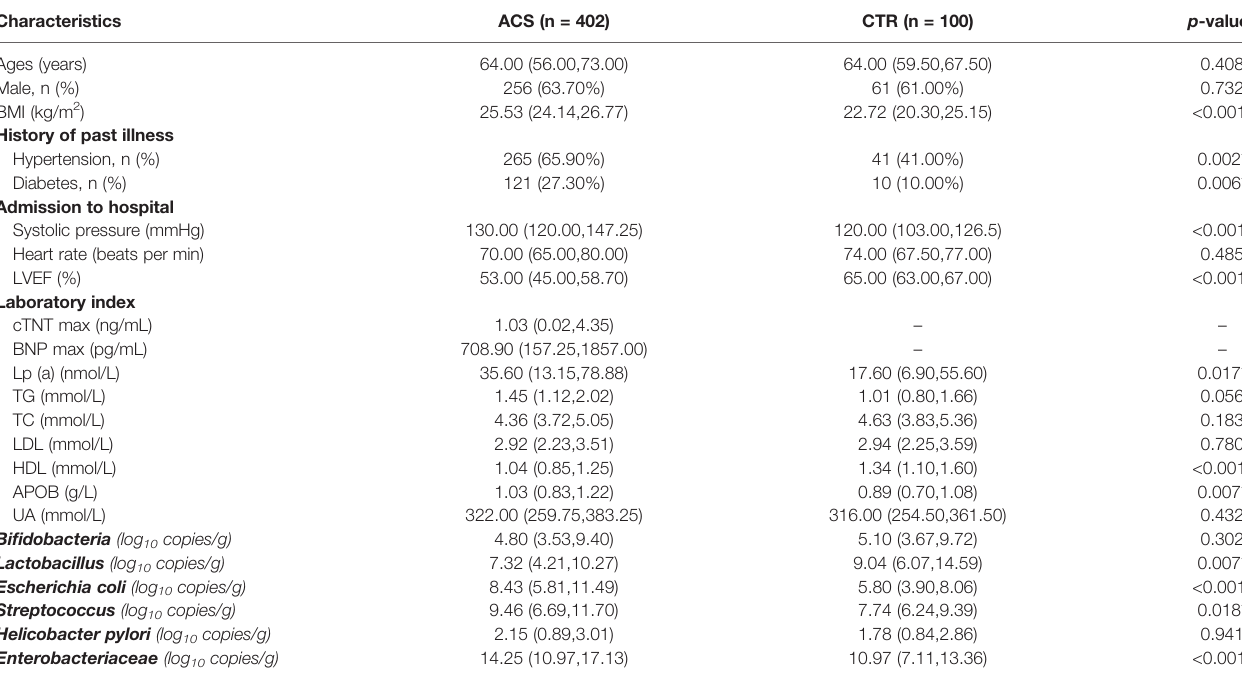
TABLE 1 | Patient